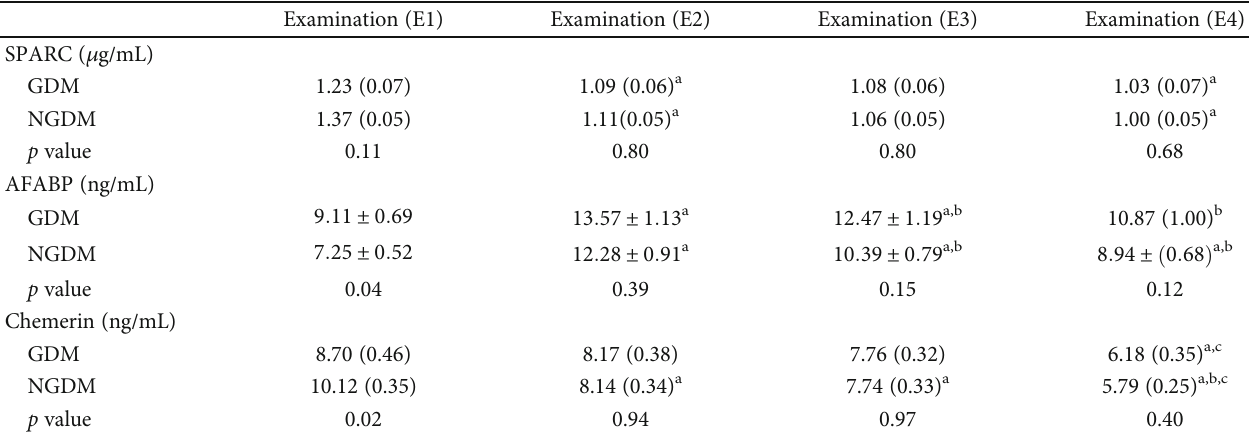
Table 3: Between- and within-group comparisons of